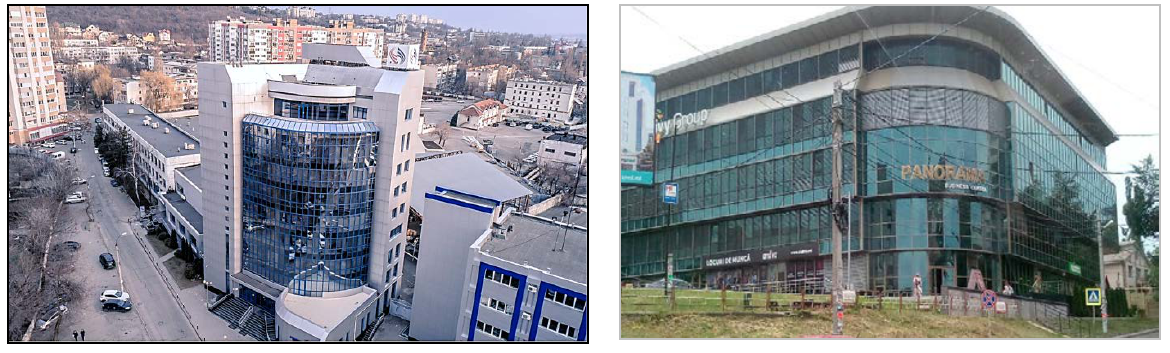
Figure 14. The Union Fenosa S.A., 2000’s. Figure 15. BC PANORAMA,